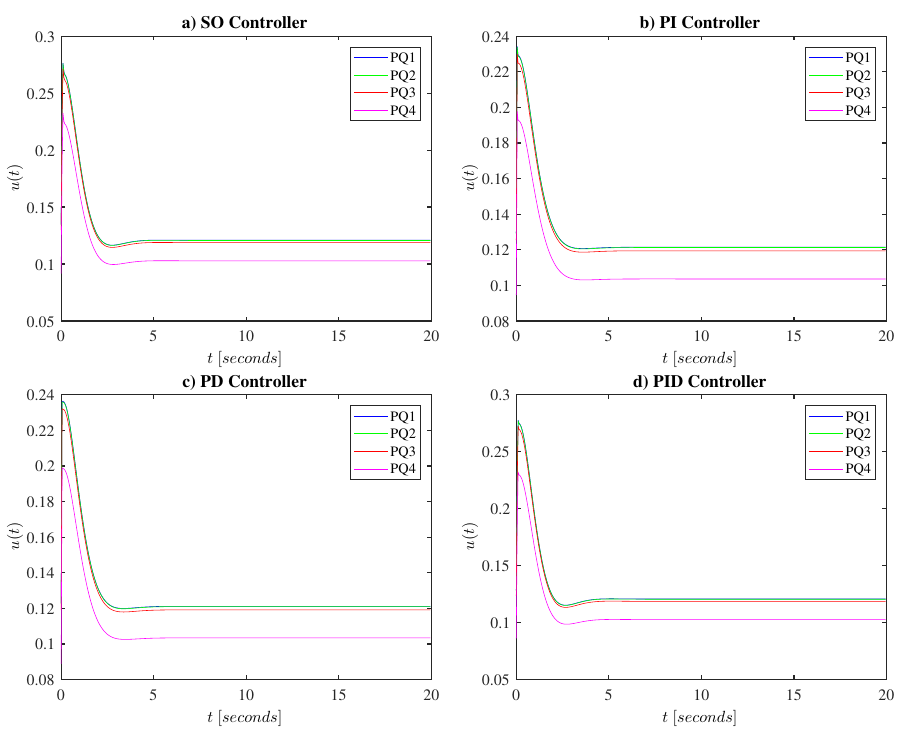
Figure 8. Optimization process results for the control action u ( t )